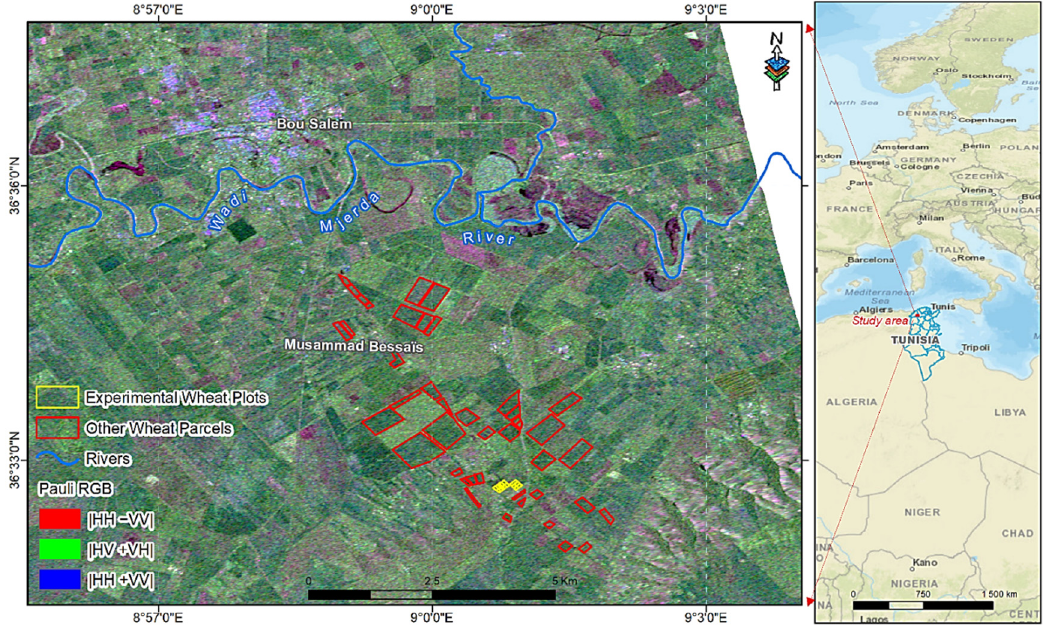
Figure 1. Location of the study area; background image RGB = (HH-VV, HV+HV, HH+VV) derived from SAR image acquired on 14 April 2015 over Boussalem Region.